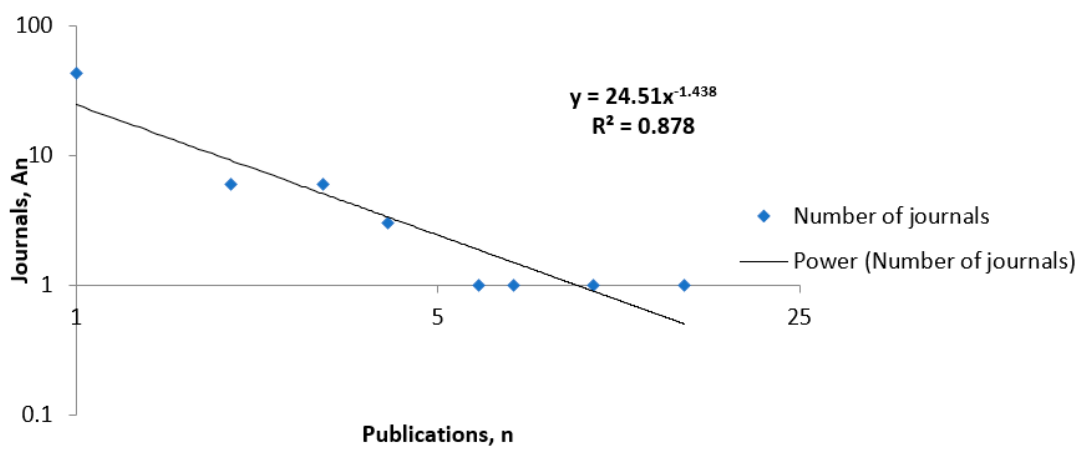
Figure 3. Application of Lotka’s law to productivity of journals on burnout in nursing.